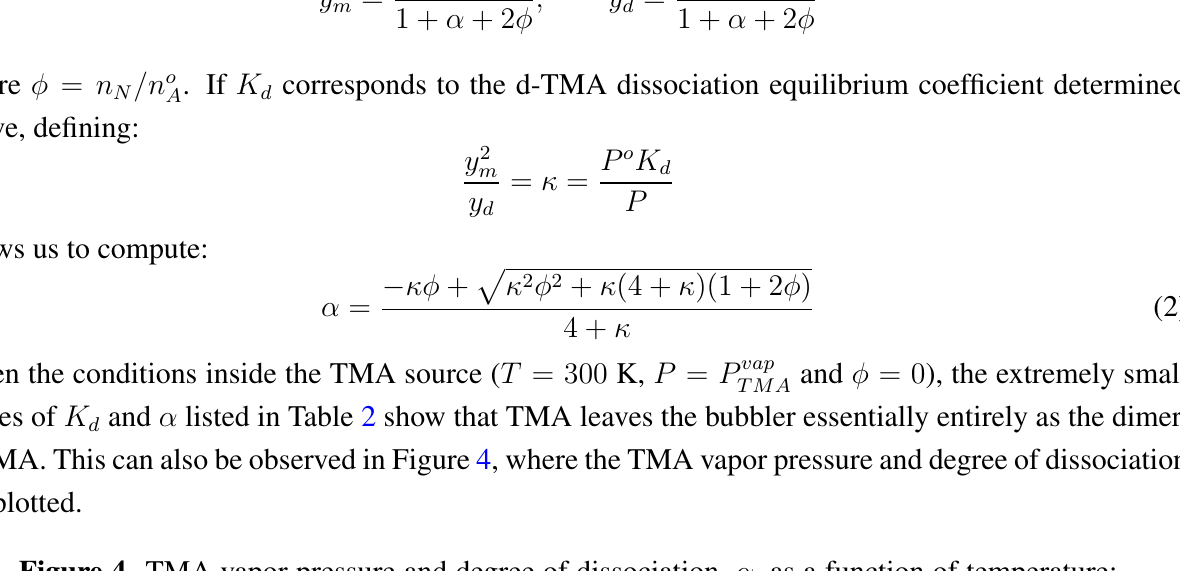
Figure 4. TMA vapor pressure and degree of dissociation, α , as a function of temperature; data presented in Table II of [43] are shown as filled red